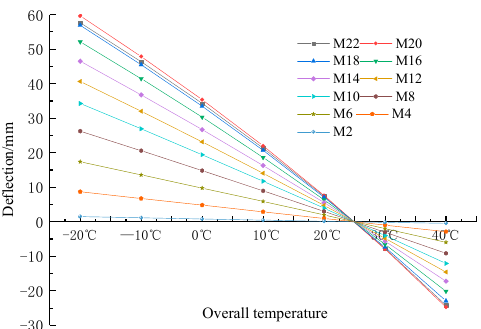
Figure 13. The deflection distribution curves of the girder with the overall temperature changed.